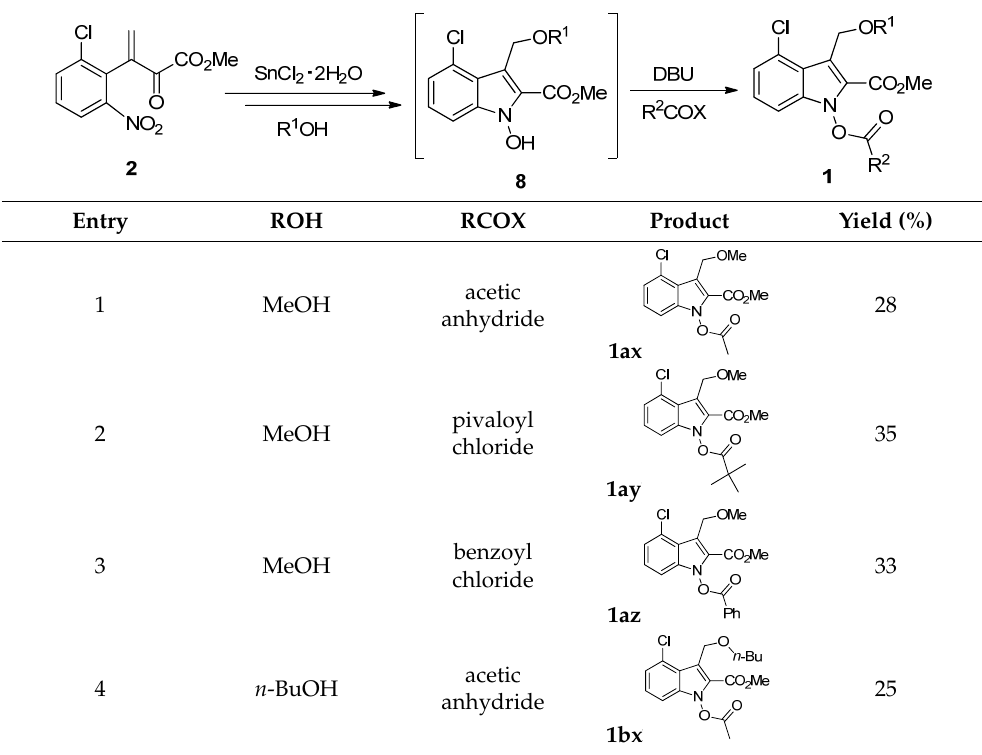
Table 2. Synthesis of derivatives of 1 ‐ acyloxyindole 1 a .